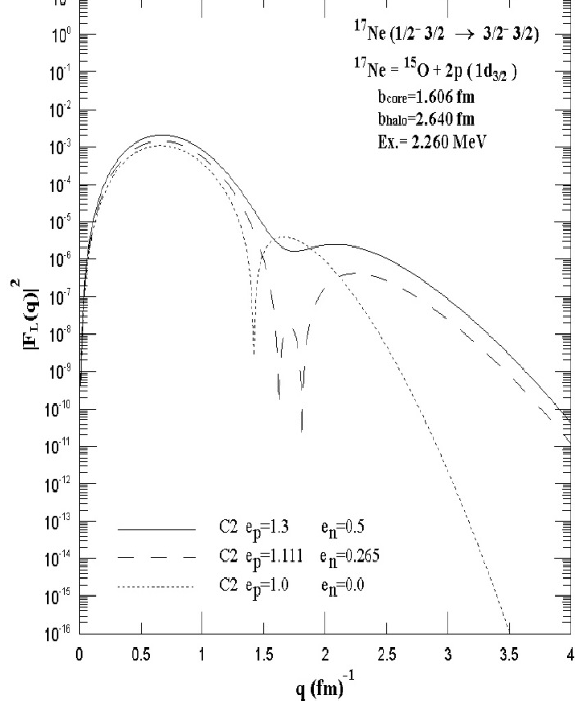
Fig. 7: The calculated inelastic longitudinal C2 form factors of 17 Ne with two protons orbit and for ( 2323   TJ  ) state. in 1d 3/2